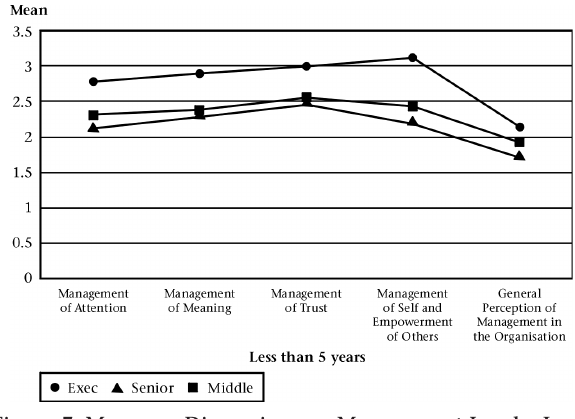
Figure 7: Mean per Dimension per Management Level – Less than Five Years of Service